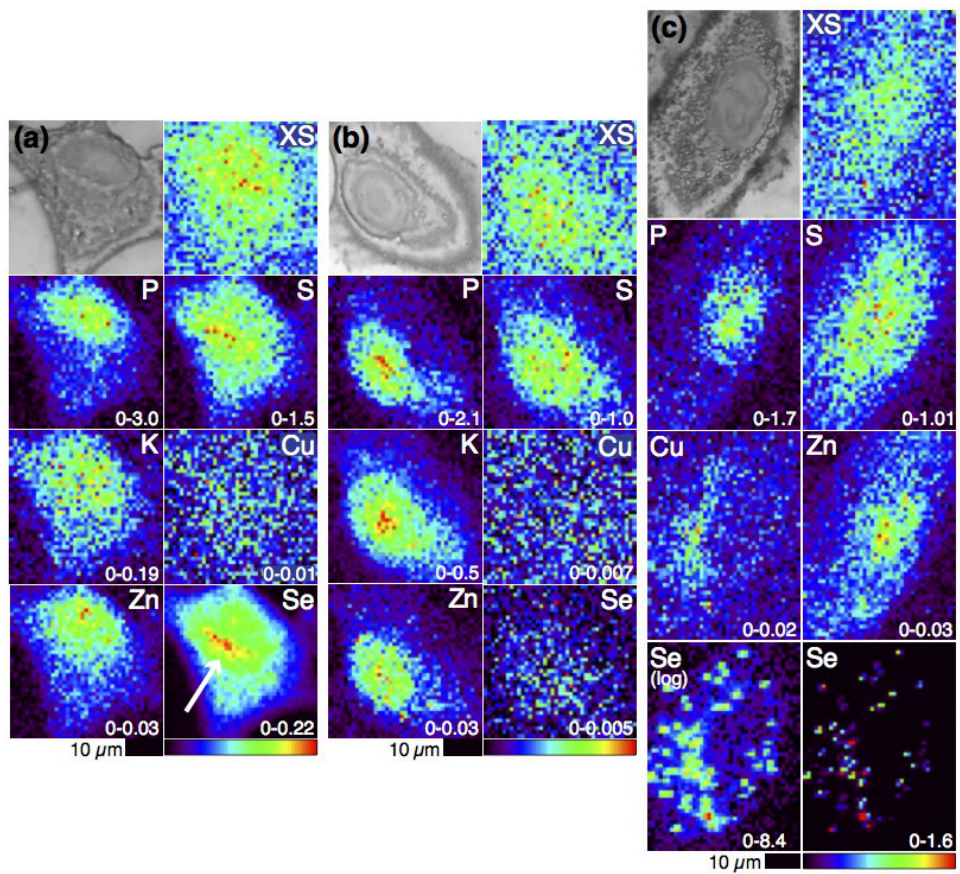
Figure 3. Optical micrographs (top left), scattered X-ray (XS) and XFM elemental distribution maps of A549 cells treated with ( a ) 50 µM SeMet (the white arrow indicates the perinuclear accumulation of Se), ( b ) 50 µM MeSeCys or ( c ) 5 µM selenite. The range of elemental area densities (quantified from standards and expressed in micrograms per square centimeter) is given in the bottom corner of each